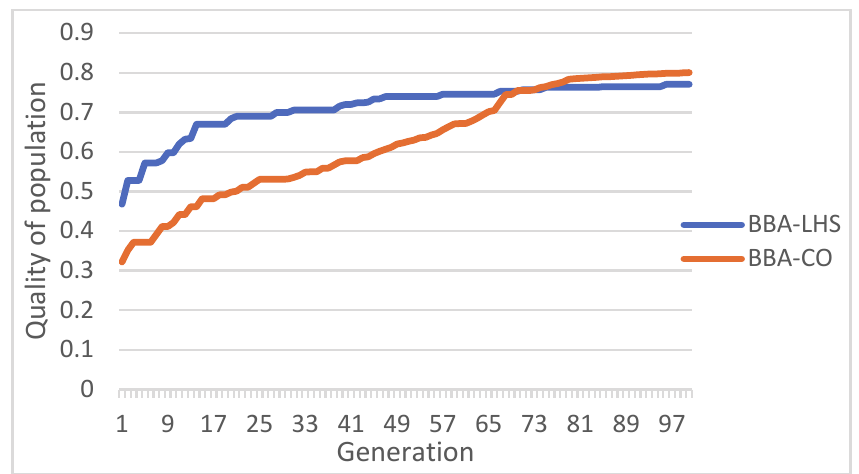
LHS and BBA CO for Reuters dataset.